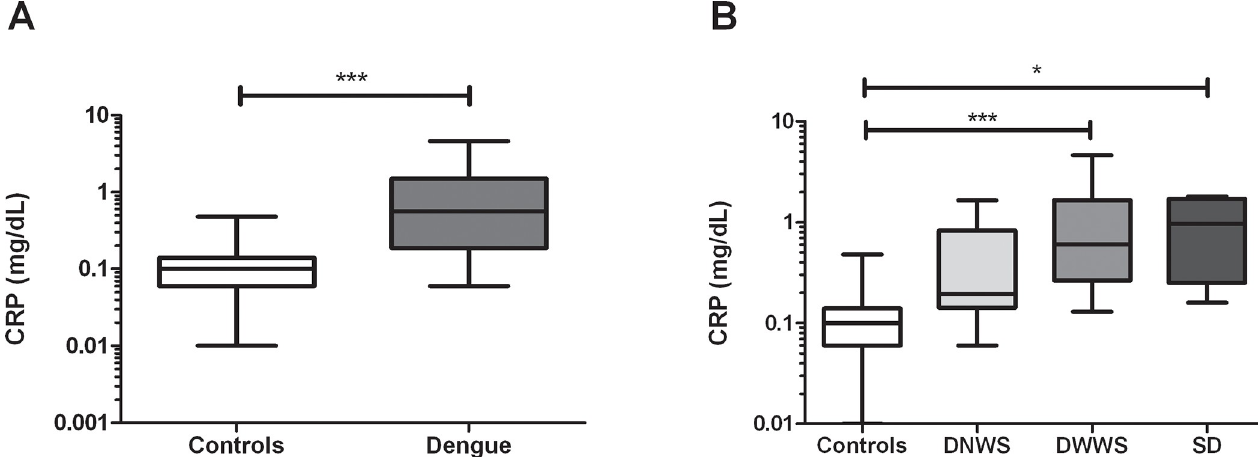
Fig 6. Serum C-reactive protein levels in dengue patients. Serum levels of CRP were quantified in dengue patients (A) total dengue patients or (B) dengue patients according to the clinical stages and healthy controls, using a colorimetric assay The results are presented as medians with maximum and minimum values (box and whisker plot). The statistical comparison was made using the Mann Whitney U and Kruskal-Wallis tests with a confidence level of 95% and post hoc tests (or multiple benchmarks) HDS of Dunn, were applied. Significant differences are represented at the top of the figure ( � p < 0.05 and ��� p < 0.001).